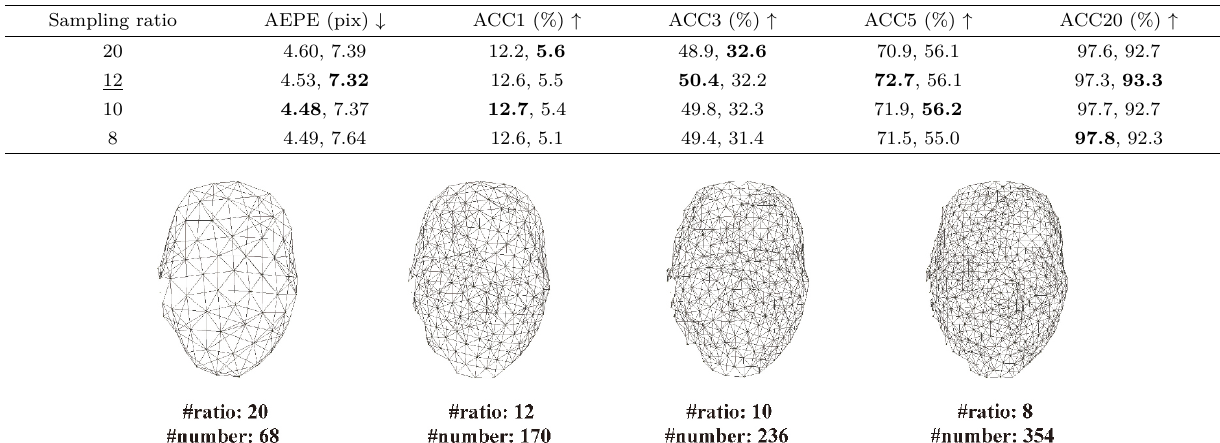
Table 2 Results for different numbers of deformation graph nodes determined by sampling ratio. Results are reported on the Synthetic Face and FaceFlowData datasets, separated by commas. Best results are highlighted in bold; settings used in our final model are underlined